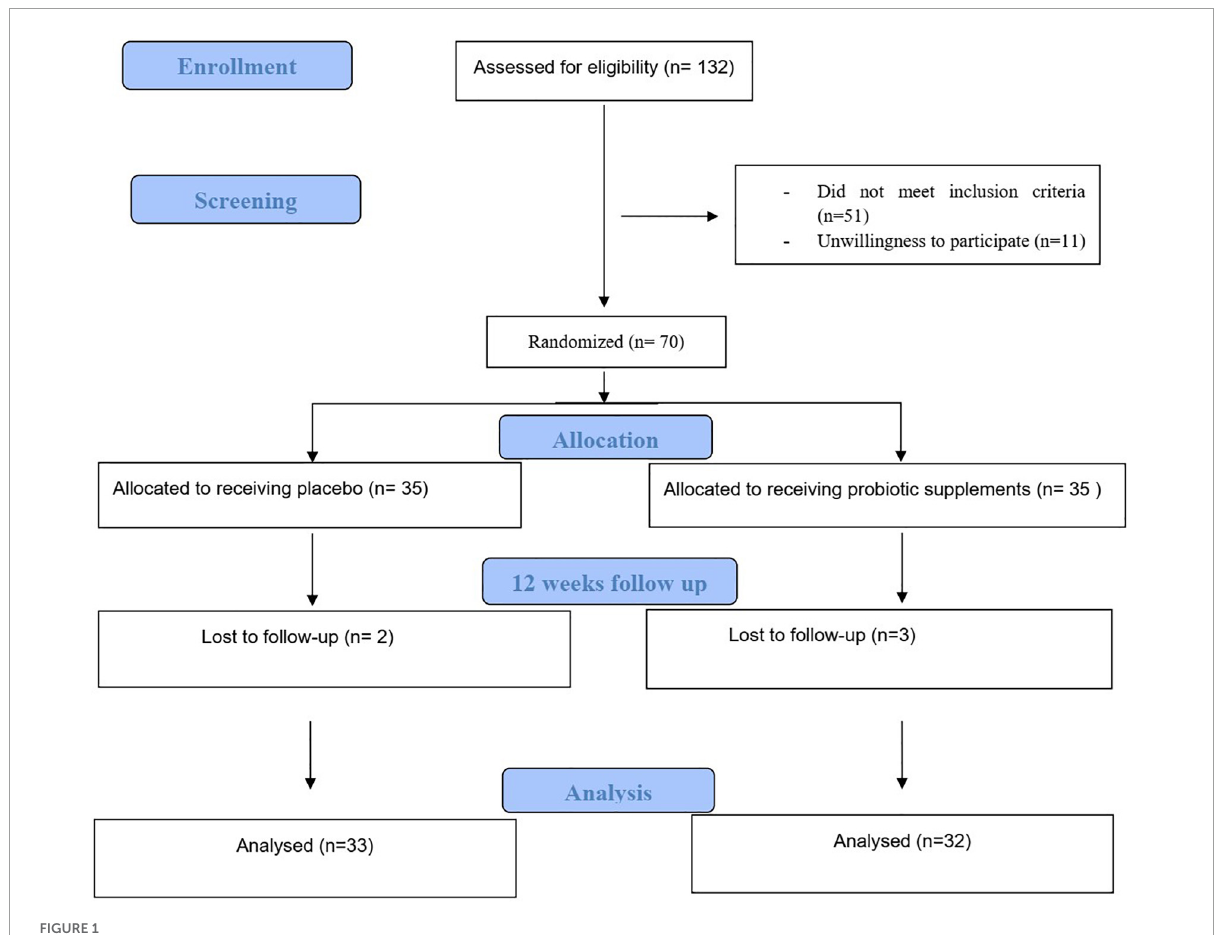
FIGURE1 Study flow